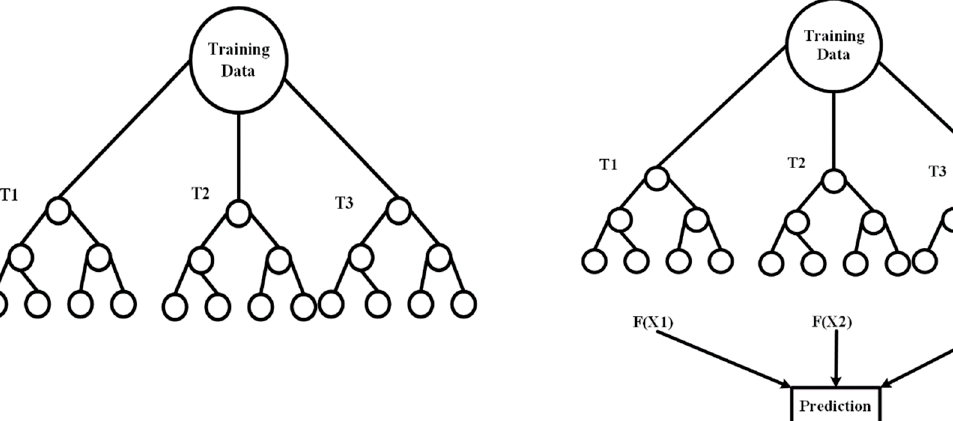
Figure 3. The schematic diagram for Random Forest Approach.